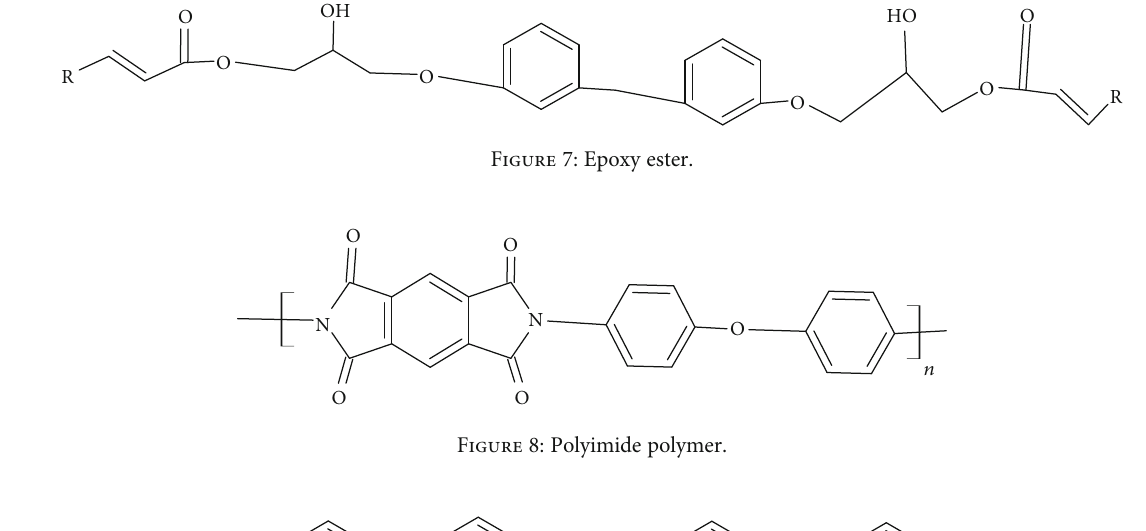
Figure 9: Polyurea.